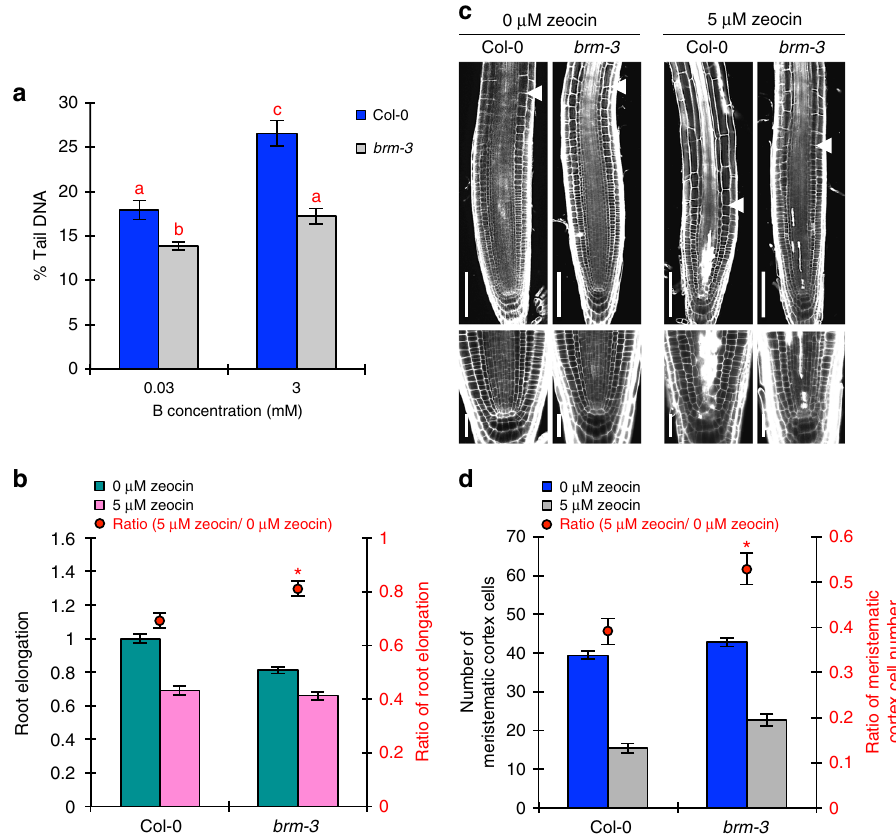
Fig. 8 Impairment of BRM function confers DNA-damage tolerance in roots. a Levels of DSBs in root tips of Col-0 and brm-3 grown under normal- and high-B conditions ( n = 111 – 115, average ± s.e.m.; P < 0.05, one-way ANOVA and Tukey ’ s HSD). b Sensitivity of Col-0 and brm-3 root growth to the DSB- inducing factor zeocin. Values for root elongation are ratios relative to the value of Col-0 under 0 μ M zeocin conditions. Red circles represent the ratio relative to the value under 0 μ M zeocin conditions ( n = 19 – 20, average ± s.e.m.; * P < 0.05, compared with Col-0, Student ’ s t -test). c Representative images of root morphology of Col-0 and brm-3 treated with zeocin. Arrowheads indicate the border between the meristem and elongating region. Below are magni fi ed images of the stem cell niche. Scale bars, 50 μ m. d Effect of zeocin treatment on the number of cortex cells in the RAM of Col-0 and brm-3 ( n = 20 – 24, average ± s.e.m.; * P < 0.05, compared with Col-0, Student ’ s t